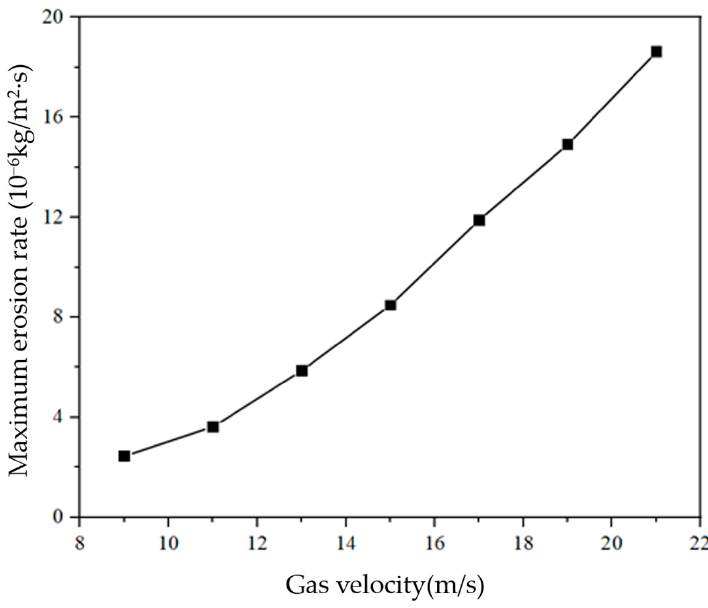
Figure 12. Relationship between maximum erosion rate and gas flow rate.